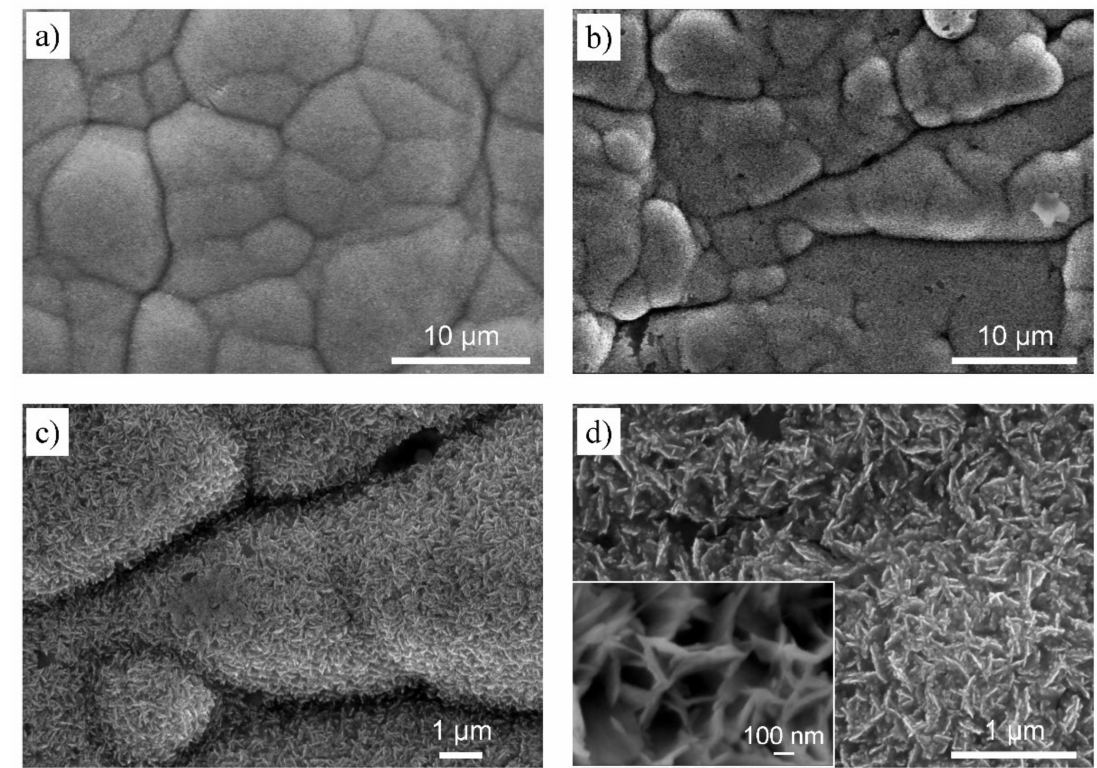
Figure 7. SEM images of the ( a ) nickel surface before deposition, ( b – d ) after deposition with the black coating at different magnifications, ( d ) nanostructured surface responsible for the black